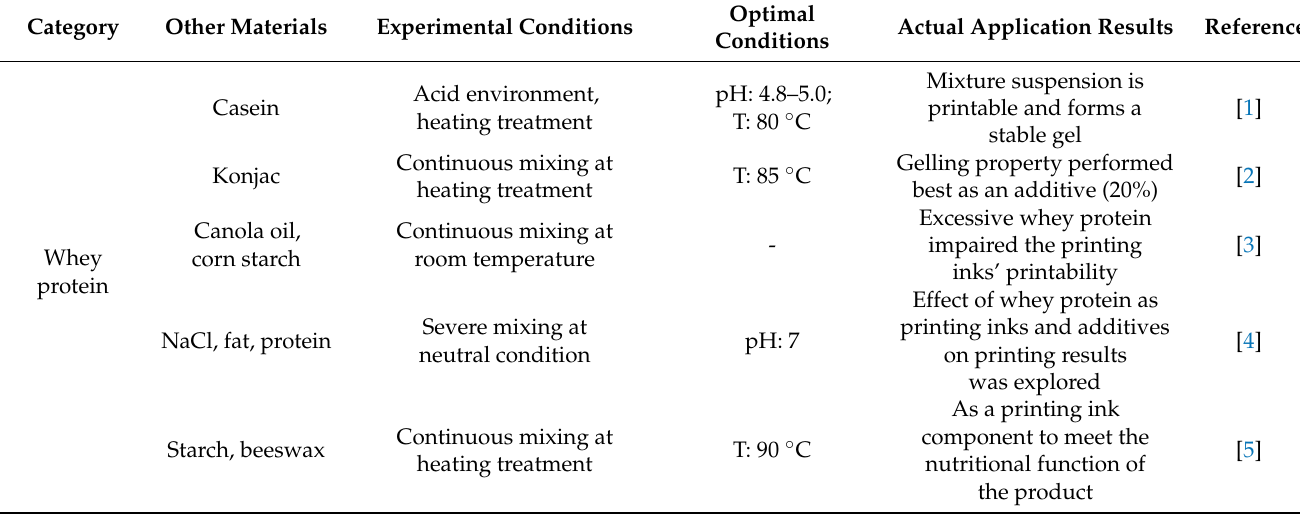
Figure 3. Overview of the influencing factors for protein function in 3D food printing. Table 1. Animal-protein-based printing inks.